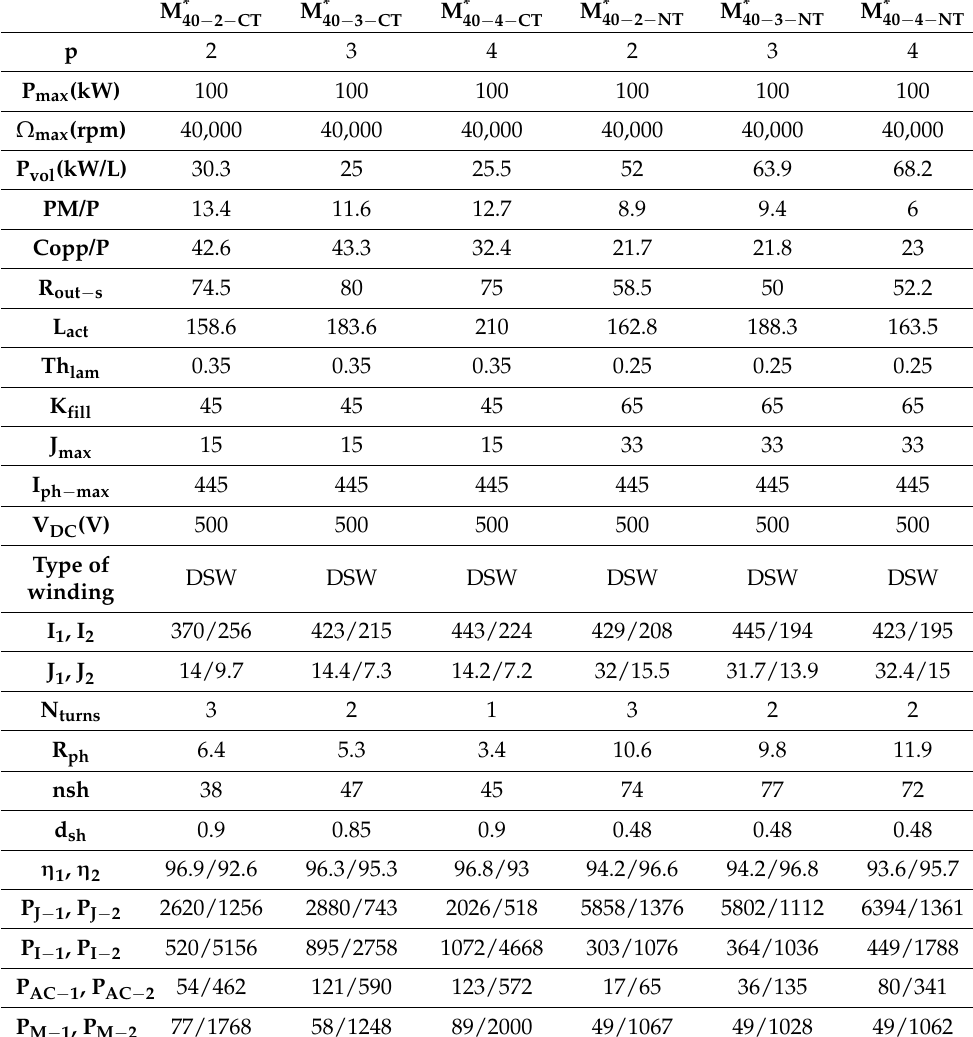
Table 8. Performances and characteristics of optimal machines operating at Ω max = 40,000